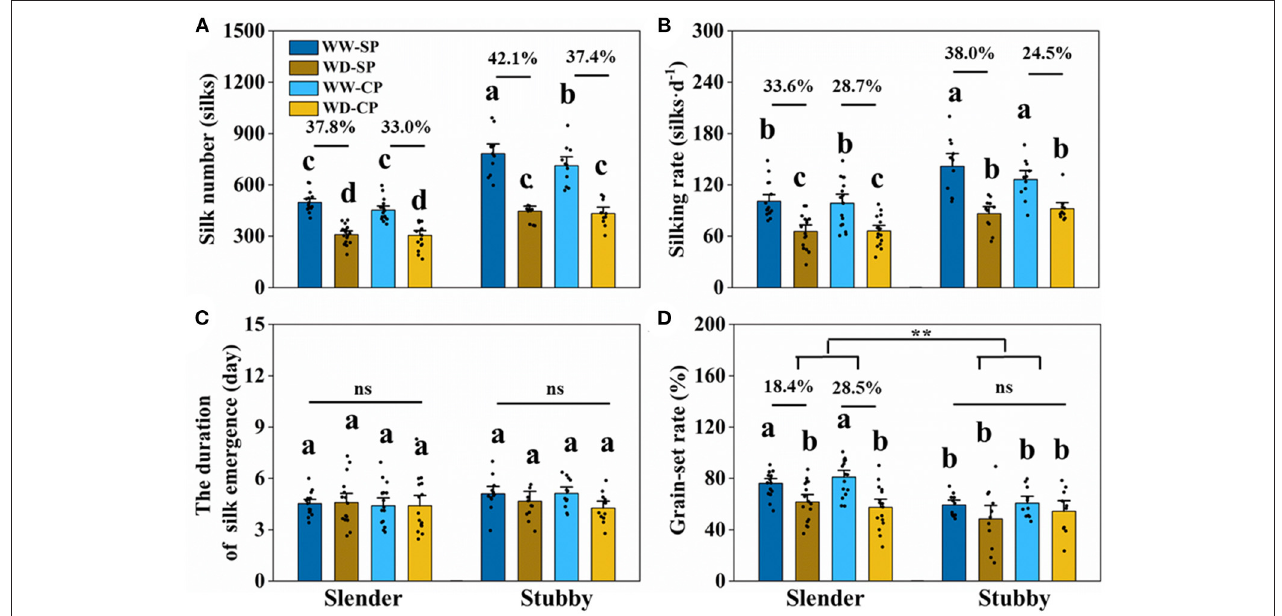
FIGURE 4 | Silk number (A) , silking rate (B) , the duration of silk emergence (C) , and grain-set rate (D) of two ear types in different pollination and water treatments. One-way ANOVA followed by Duncan’s new multiple range test, n ≥ 3; letters (a, b, and c) indicate significant differences ( p < 0.05). Data represent the change rate of water-deficit treatments compared to well-watered treatments. Asterisks indicate that the loss rate between the slender and stubby ears was significantly different ( t -test, n ≥ 3: ** p < 0.01). d, day; ns, no significance; SP, synchronous pollination; CP, continuous pollination; WW, well-watered treatment; WD, water-deficit treatment.